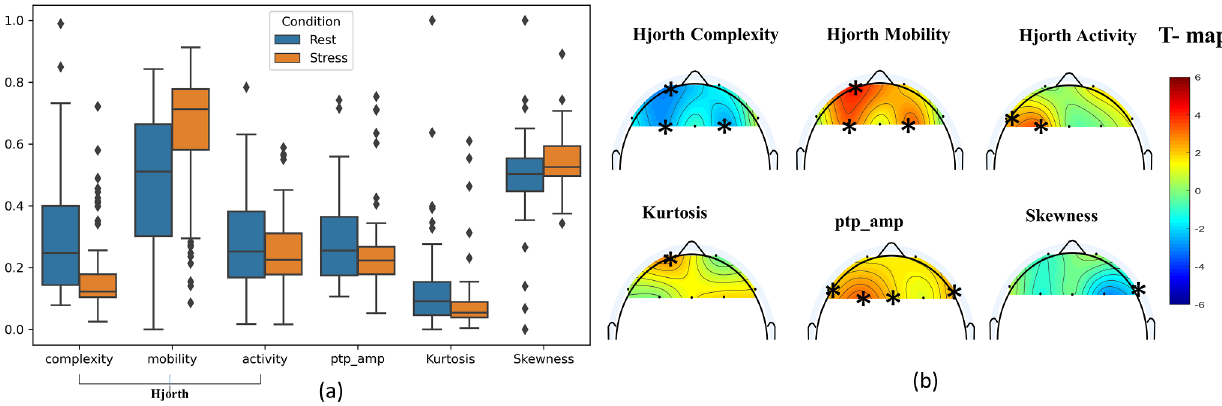
Figure 5. ( a ) The mean and standard deviation using scatter for time-domain features of the Hjorth complexity, Hjorth mobility, Hjorth activity, kurtosis, peak-to-peak amplitude ( ptp _ amp ), and skewness of EEG signals at 1–30 Hz for stress and rest conditions. The difference between stress and rest is shown using T-maps in ( b ). The star (*) symbols denote statistically significant electrodes using topographic maps (two-sample t -test; p < 0.01, Bonferroni correction).